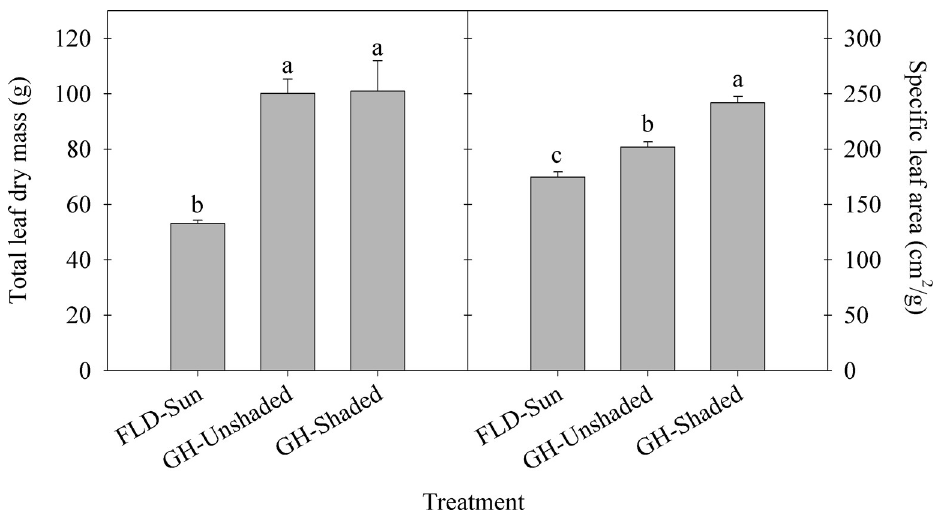
Fig 3. Total leaf dry mass and specific leaf area of kratom cultivated under varying radiance. FLD = field; GH = greenhouse. Data were pooled from four random replicates per treatment (n = 12) and means sharing the same letter are not statistically different by Tukey’s honest significant difference test at P < 0 . 05 . Error bars indicate the standard